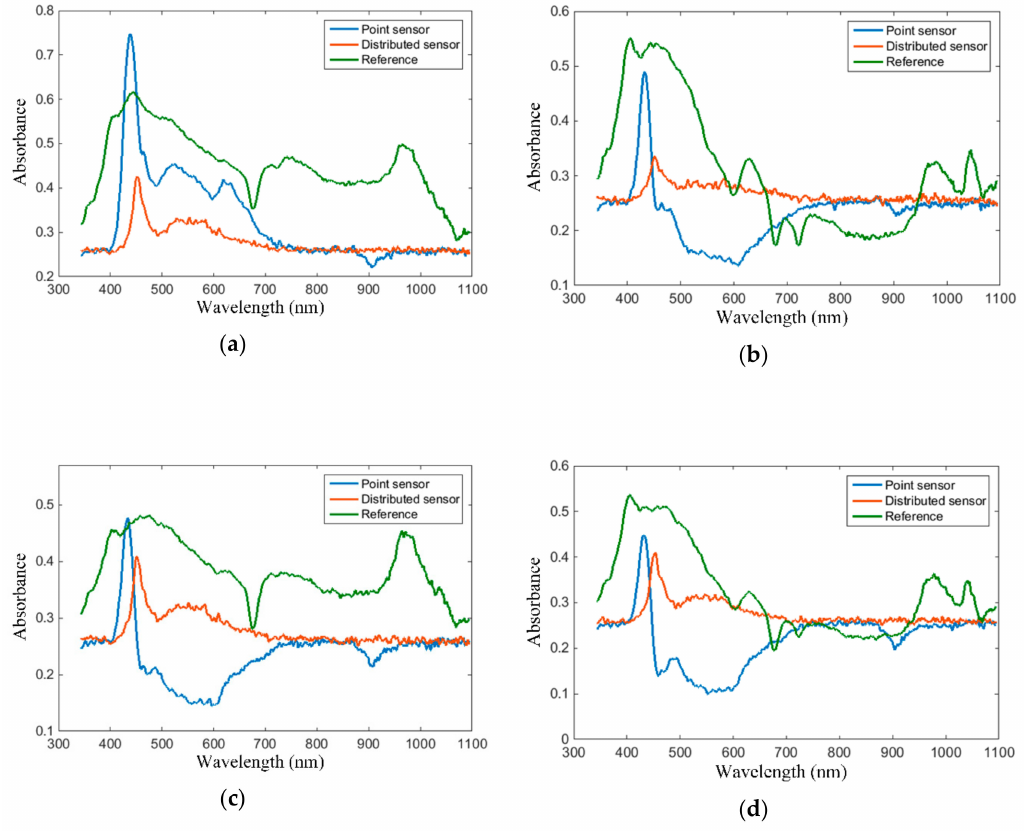
Figure 15. White wine absorption spectra, acquired via the proposed intra-oral sensor implementations, with a blue line for the point sensor, orange line for the extended sensing area sensor, and green line for standard spectroscopic method, respectively: ( a ) blended dry, ( b ) blended medium dry, ( c ) Yellow of Transylvania, ( d ) Sauvignon